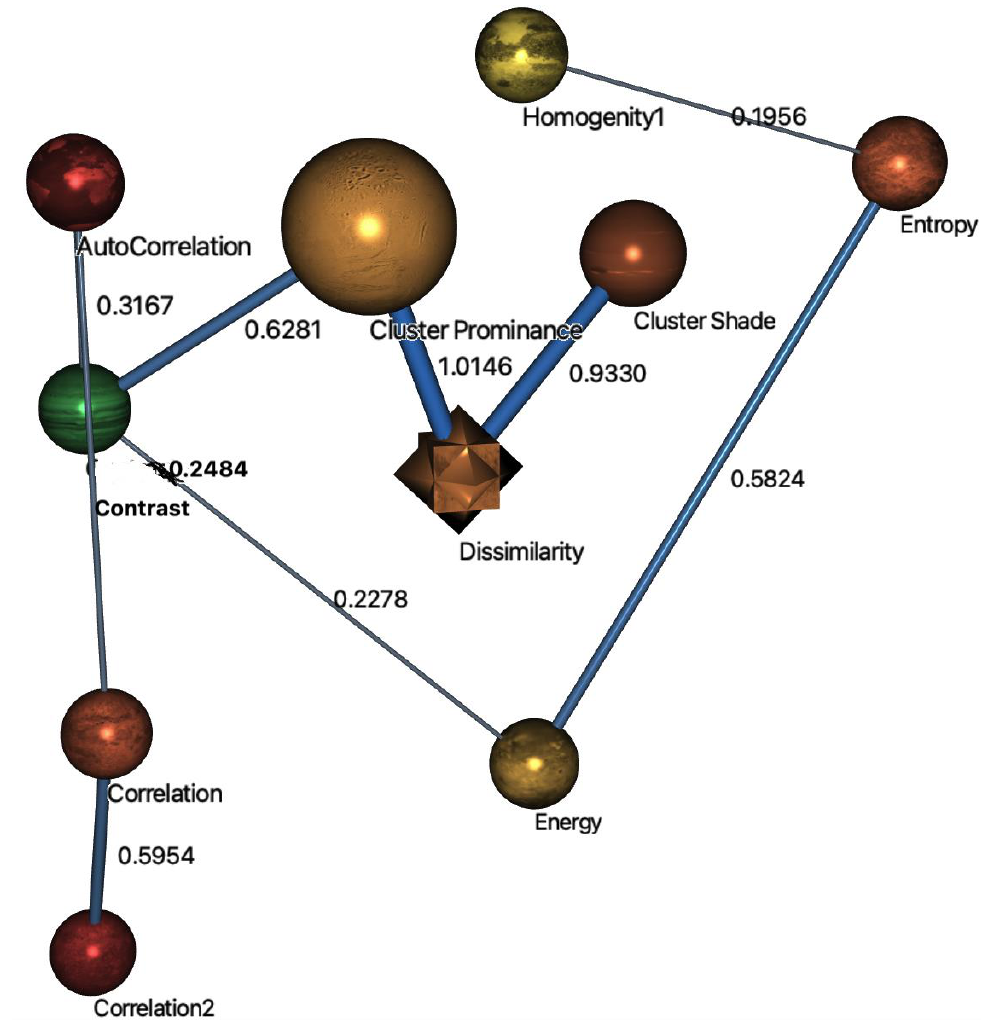
Figure 3. Arc analysis mutual information ( MI ) with node size of normalized mean.